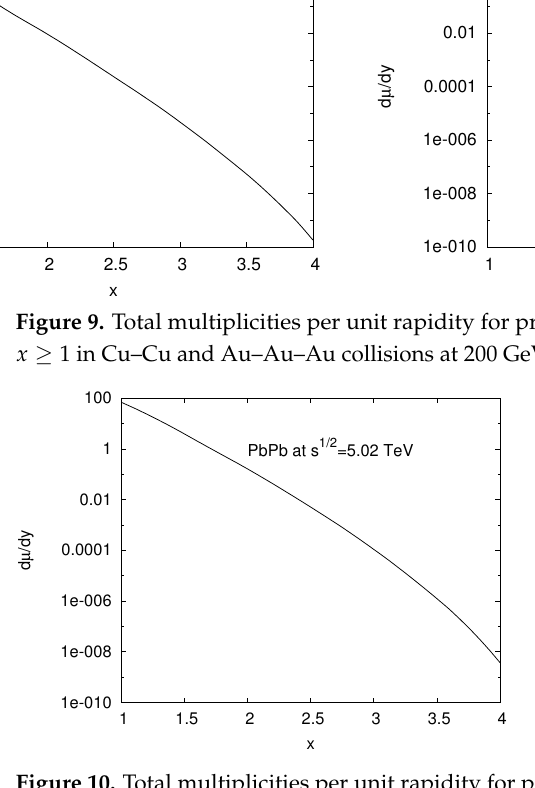
Figure 10. Total multiplicities per unit rapidity for production of cumulative pions at cumulatively x ≥ 1 in Pb–Pb collisions at 5.02